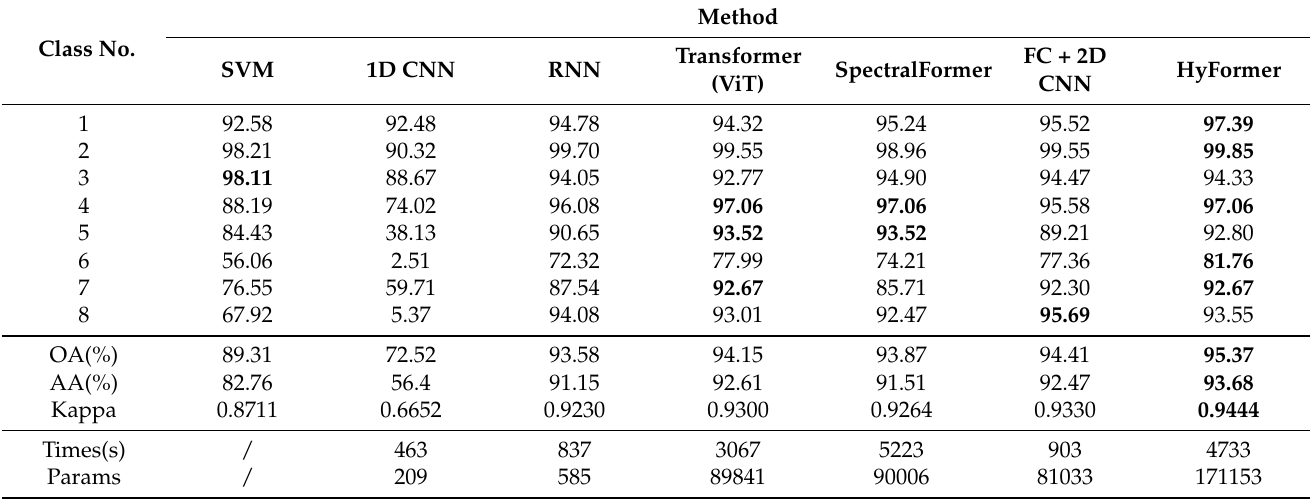
Table 6. Comparison of classification results of different classification methods applied on the testing set of Changxing County, 2022.